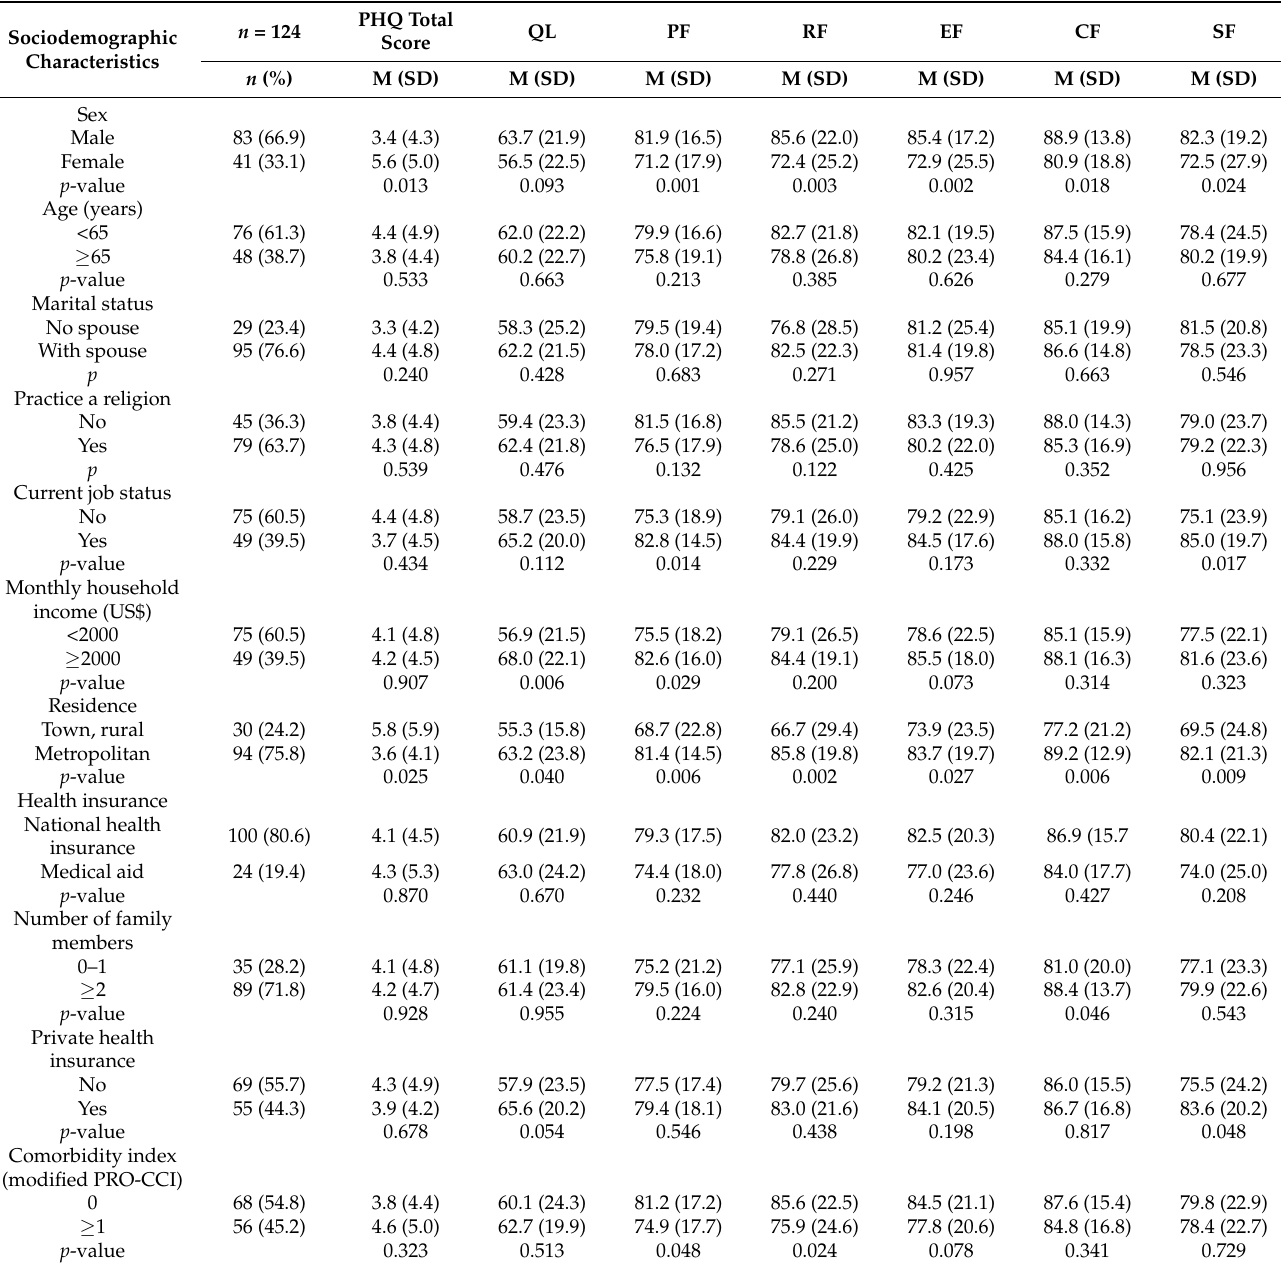
Table 1. Univariate analyses: association between sociodemographic characteristics and depression and health-related quality of